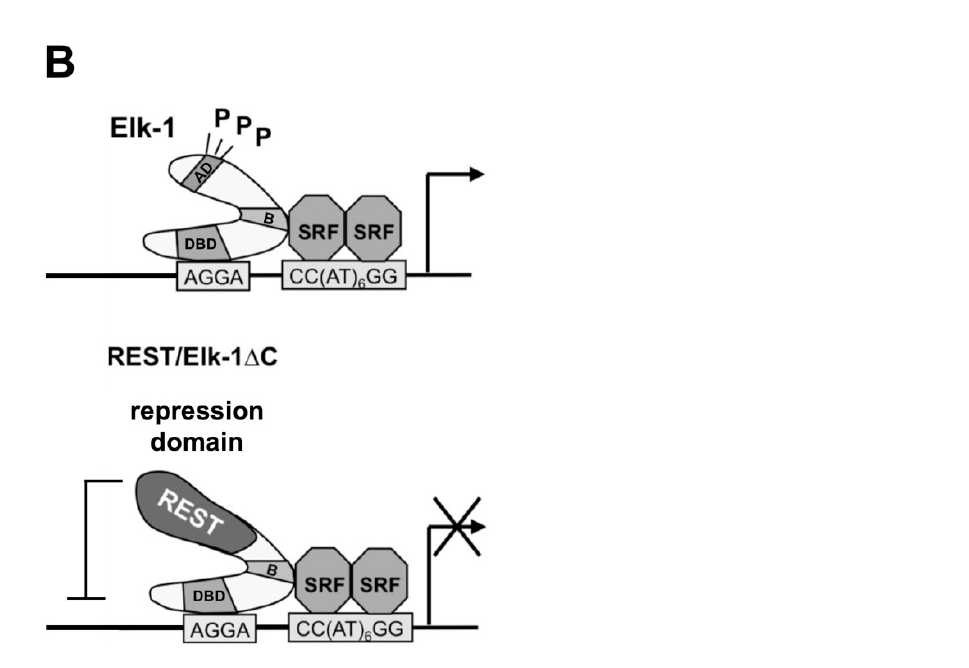
Figure 3. A dominant-negative mutant of Elk-1 allows the investigation of the biological function of Elk-1. ( A ) Modular structure of Elk-1 and REST/Elk-1 ∆ C, showing the N-terminal DNA binding domain, the SRF binding site (domain B) and the C-terminal transcriptional activation domain. The REST/Elk-1 Δ C mutant lacks the activation domain, but contains instead the N-terminal transcriptional repressor domain from REST. ( B ) Mechanism of REST/Elk-1 Δ C interference. The binding of TCF proteins to the SRE and to SRF is blocked. Additionally, histone deacetylases are recruited to the transcription units. P, Elk-1 phosphorylation site.